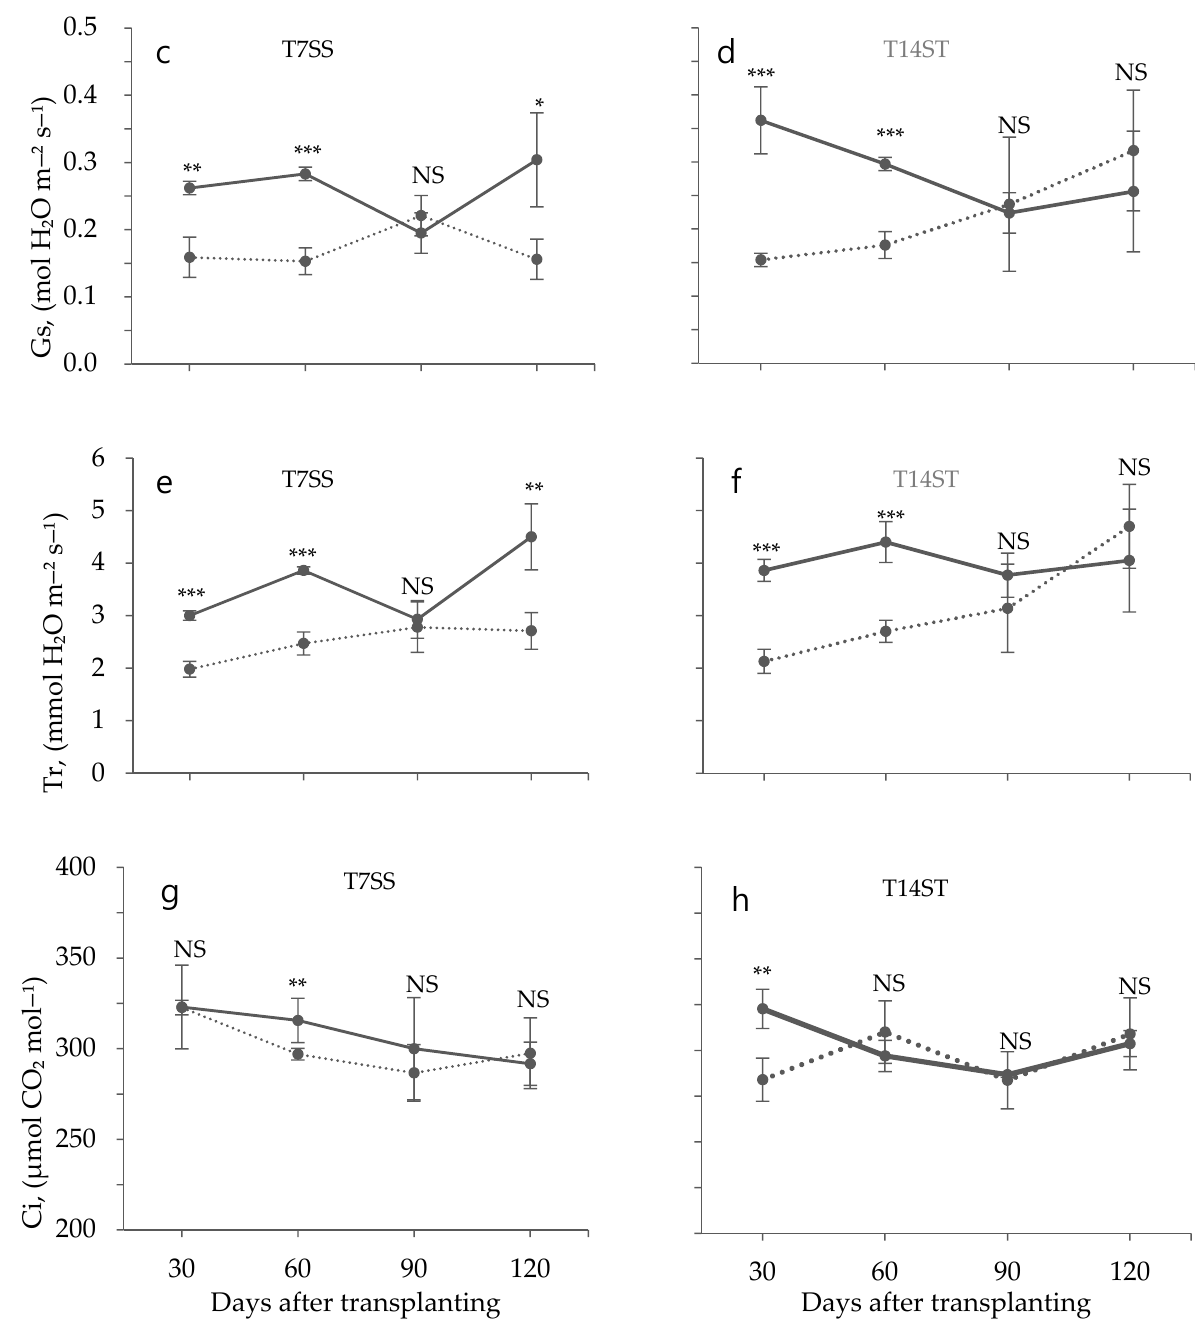
Figure 2. Changes in photosynthetic parameters of cherry-fruit-type accessions sensitive or tolerant to low night temperature grown in 10 and 15 ◦ C. P N —photosynthesis rate ( a , b ) Gs—stomatal conductance ( c , d ), Tr—transpiration rate ( e , f ) and Ci—intercellular CO 2 concentration ( g , h ) were presented for LNT-sensitive and -tolerant accessions, respectively. SS: small sensitive, ST: small tolerant. Values are means ± SD (n = 3). NS, *, ** and *** indicate not significant and significant at the p ≤ 0.05, p ≤ 0.01 and p ≤ 0.001 levels in t -test, respectively.